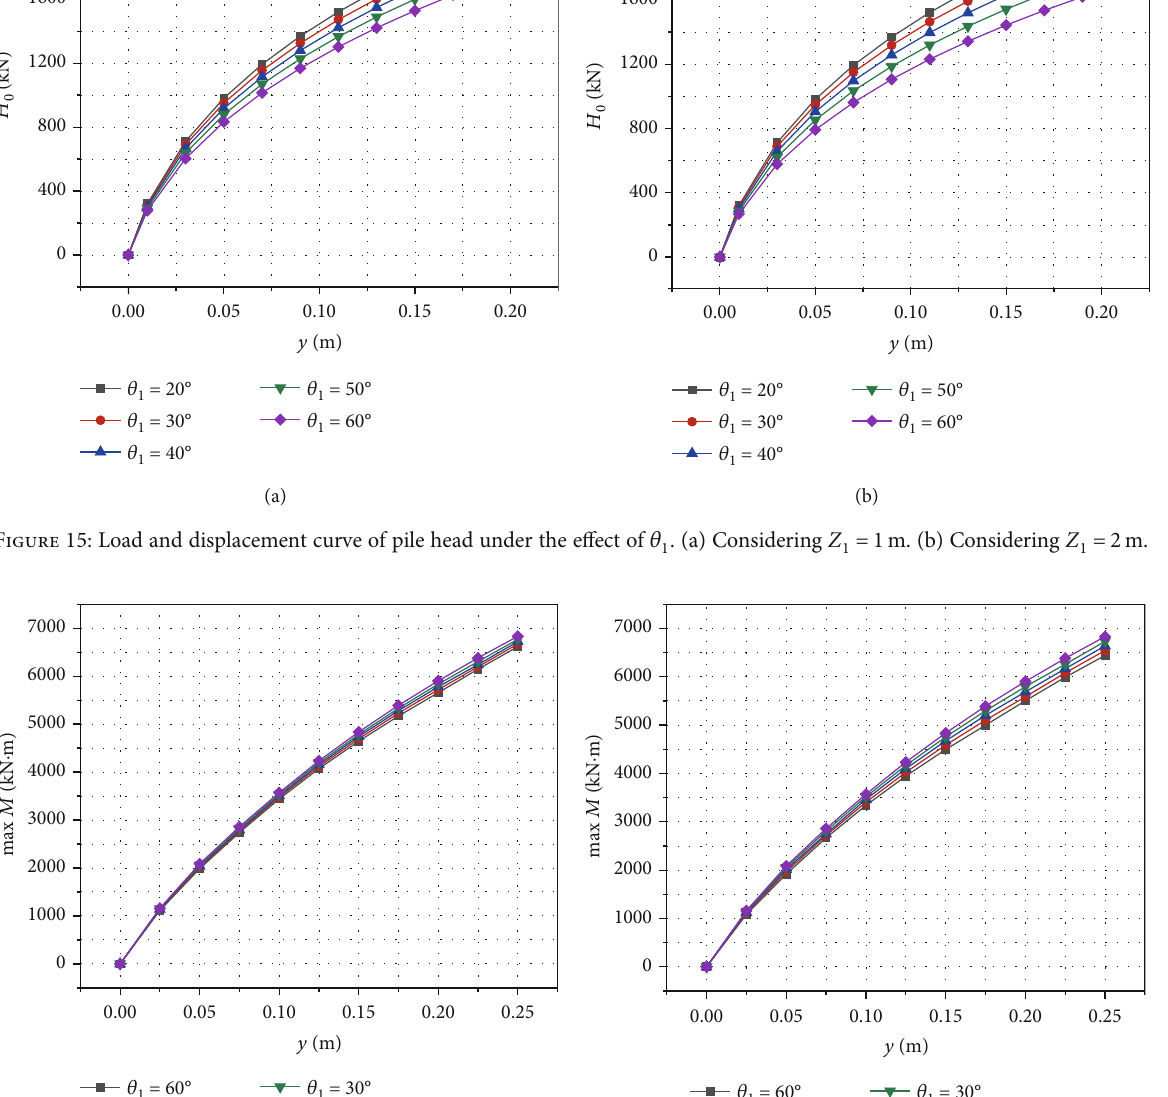
on maximum bending moment. (a) Considering Z 1